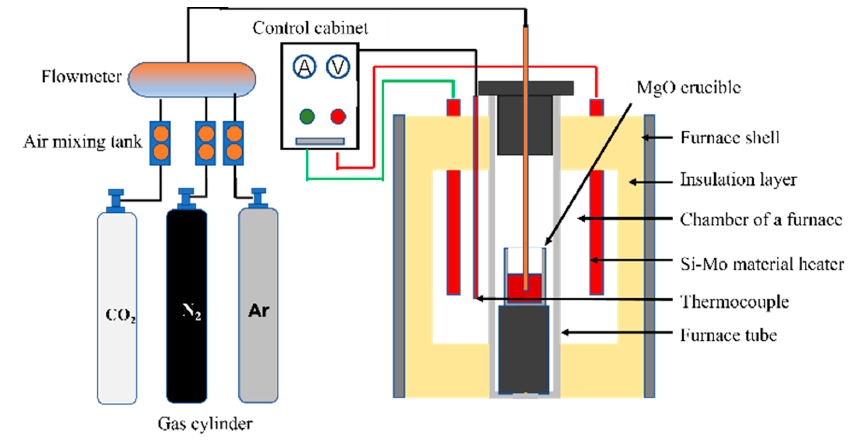
Figure 1. Schematic diagram of the experimental device.